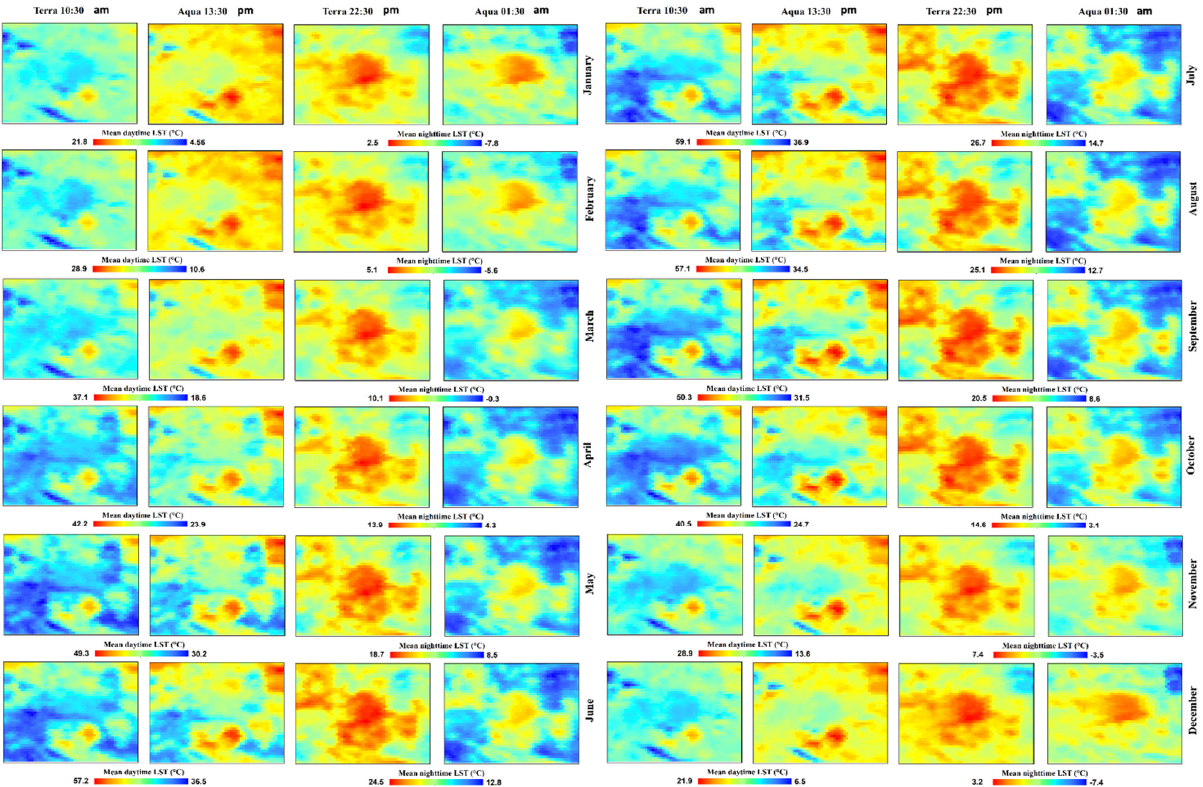
Figure 5. Monthly spatial variation of mean LST (average over 2003–2019) during daytime (Terra 10:30 am and Aqua 13:30 pm) and nighttime (Terra 22:30 pm and Aqua 01:30 am) from January to June.